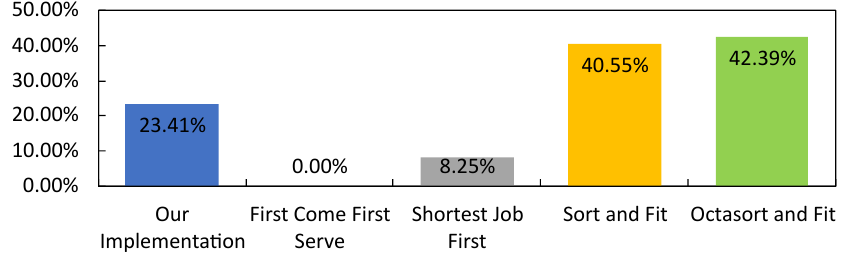
Figure 12. Average scheduler optimization when compared against the First Come First Serve as